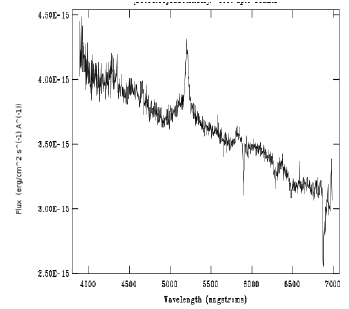
Figure 1. Spectrum of 3C 454.3 achieved in June 2008; the spectrum is given in the observer frame. A bright and intense emission line correspond to MgII [2800 Angstroms], absorption lines are